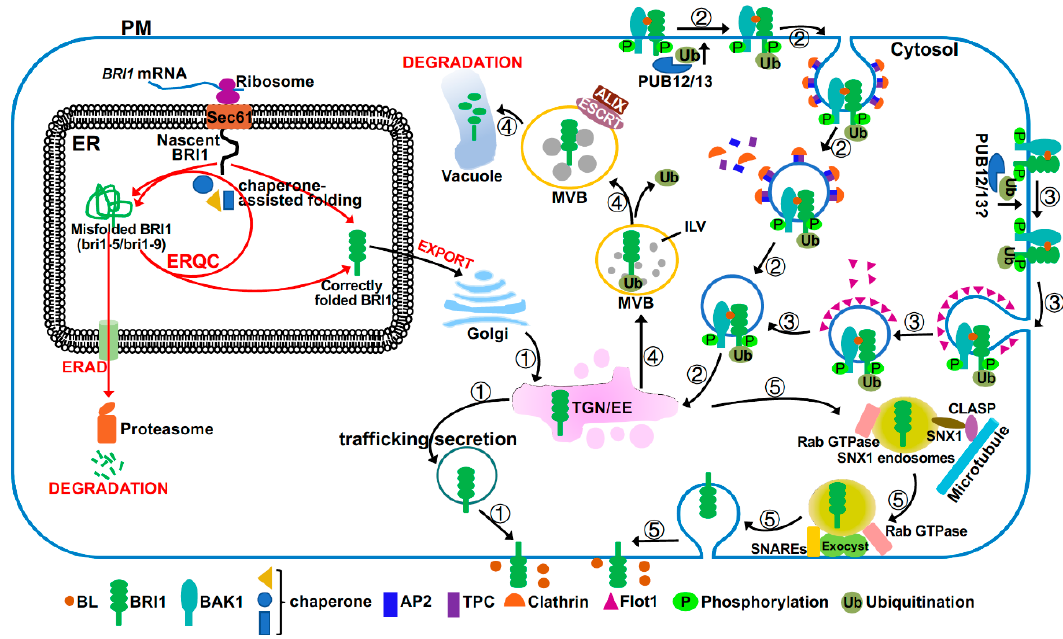
Figure 3. A current model of regulating the BRI1 abundance on the plasma membrane (PM) . Newly synthesized BRI1 is translocated through the Sec61 translocon from the ER (endoplasmic reticulum)-associated ribosomes into the ER where it undergoes chaperone-assisted protein folding. Correctly folded BRI1 is exported into the Golgi to continue its secretory journey through the TGN ( trans -Golgi network) / EE (early endosome) to be targeted on the PM (1), whereas the incorrectly / misfolded BRI1, such as its mutant variants bri1-5 and bri1-9, are retained in the ER by ERQC (ER quality control) for refolding and degradation via ERAD (ER-associated degradation) that involves retrotranslocation and cytosolic proteasome. The PM-localized BRI1 or BRI1 / BAK1 heterodimer is presumably ubiquitinated by the PUB12 / 13 (plant U-box protein12 / 13) E3 ligases and undergoes constitutive CME (clathrin-mediated endocytosis)-mediated internalization (2) or ligand-induced CIE (clathrin-independent endocytosis)-mediated internalization (3). The endocytosed BRI1 at the TGN / EE could be packaged into ILVs (intraluminal vesicles) and delivered to the vacuole for degradation via ESCRT (endosomal sorting complex required for transport)-mediated biogenesis of MVBs (multivesicular bodies) and eventual MVB-vacuole fusion (4). Alternatively, the TGN / EE-localized BRI1 can be recycled back to the PM via retromer-mediated cargo selection, microtubule-assisted vesicle tra ffi cking, and exocyst / SNARE (soluble N-ethylmaleimide-sensitive factor-attachment protein receptor)-involved exocytosis (5). The circled numbers indicate di ff erent secretion / tra ffi cking routes. SNX1 (sorting nexin1) is one of the core retromer subunits, CLASP (cytoplasmic linker-associated protein) is a microtubule-associated protein, and ALIX (the Arabidopsis homolog of apoptosis-linked gene 2-interacting protein X) is a cytosolic ESCRT-associated protein.